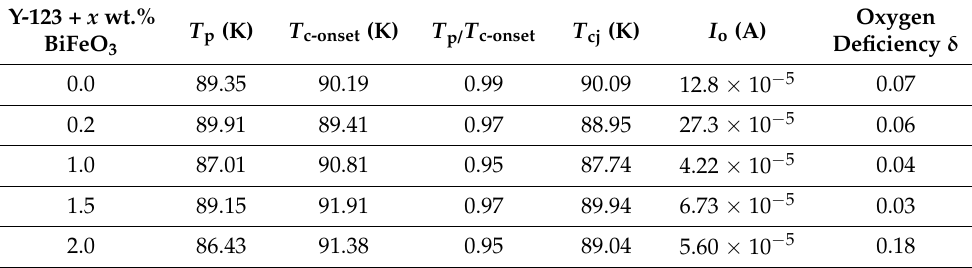
Figure 6. A general view of a polycrystalline sample illustrates the inter-grain current, intra-grain current, and inter-grain coupling.